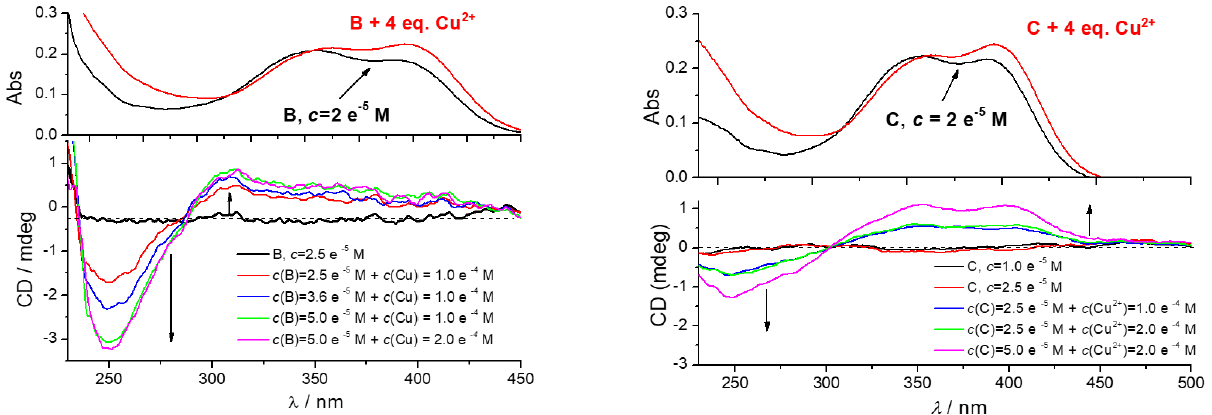
Figure 5. Effect of CuCl 2 addition to CD spectra of B ( left ) or C ( right ). The UV/Vis spectra given at the top are taken from experiments given in Supplementary Materials, Figure S16. Done at pH 7, sodium cacodylate buffer, c = 50 mM.